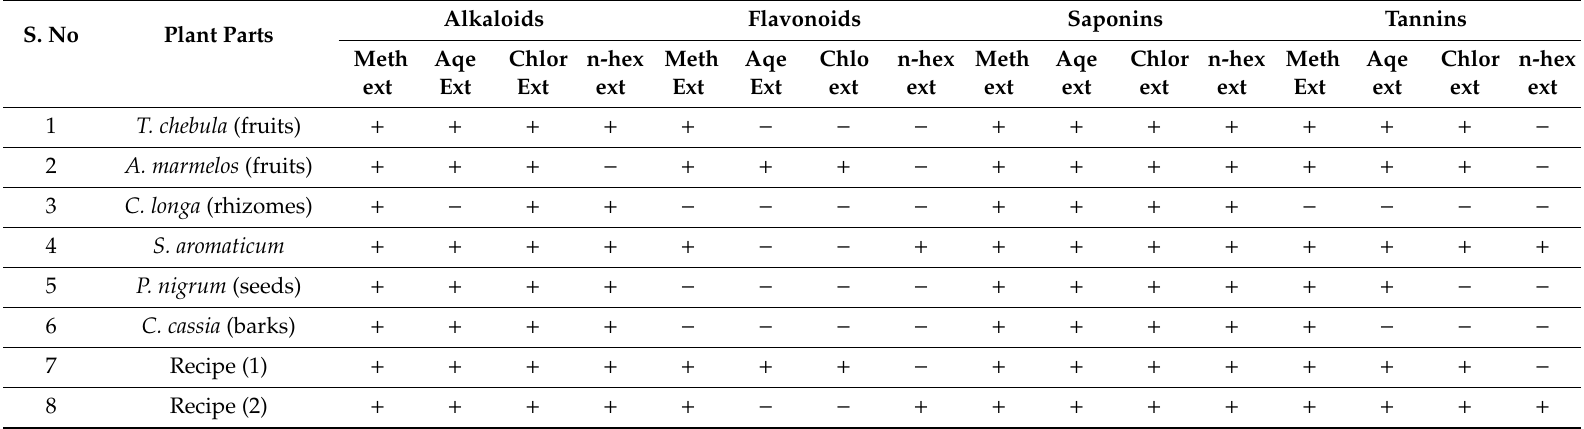
Table 1. Qualitative phytochemical screening of alkaloids, flavonoids, saponins and tannins of medicinal plant parts and their recipes. S. No Plant Parts